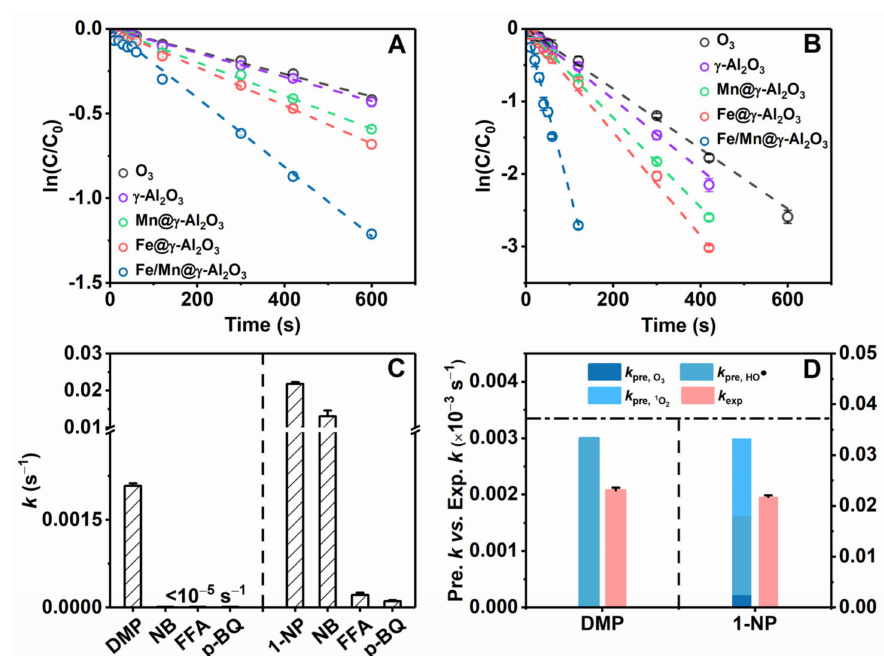
Figure 2. The degradation of DMP ( A ) and 1 − NP ( B ) during the catalytic ozonation. The degradation of DMP or 1 − NP during the Fe/Mn@ γ − Al 2 O 3 /O 3 system in presence of different quenchers (NB/FFA/ p − BQ, 100 mM) ( C ) or different probes (NB/FFA, 5 µ M) ( D ). Conditions: [O 3 ] = 0.02 mM, [catalyst] = 200 mg L − 1 , the molar ratio of Fe/Mn = 1.5, [DMP]/[1 − NP] = 50 µ M, pH = 7.0 ± 0.1 with 2 mM phosphate buffer. The probe test is detailed in Text S1. Table 1. The estimated and experimental observed removal rate constants of DMP/1 − NP.